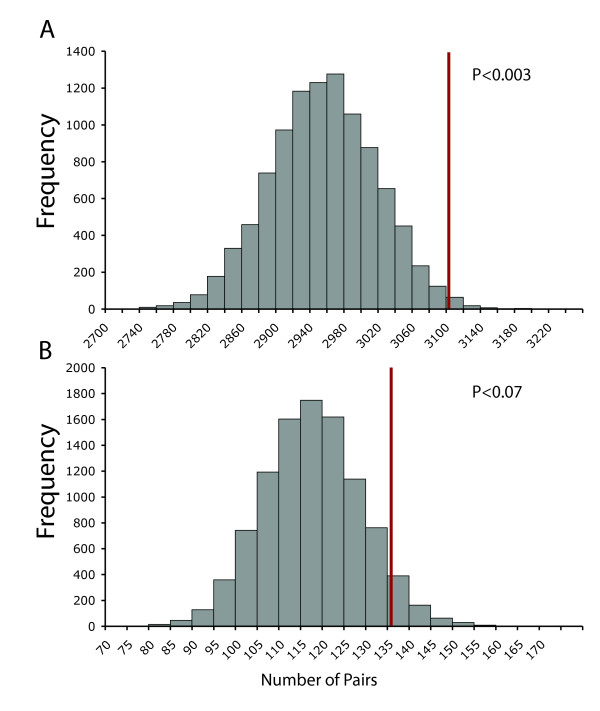
Conserved genes and disease genes are not randomly distributed throughout the mouse genome. Panel A: Conserved genes are found to have conserved genes as neighbors more often than expected if gene position was random. The results of 10,000 randomization trials are shown in the histogram, while the observed data (number of conserved genes with at least one conserved neighboring gene) is shown with the red line. Panel B: Disease genes neighbor other disease genes more often than expected by chance. The results of 10,000 randomization trials are shown in the histogram, while the observed data (number of disease genes with at least one disease gene as a neighbor) is shown with the red line.